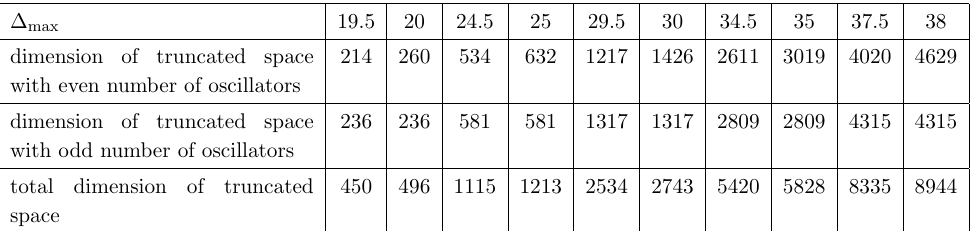
Table 10. Dimensions of truncated spaces of NS fermions.